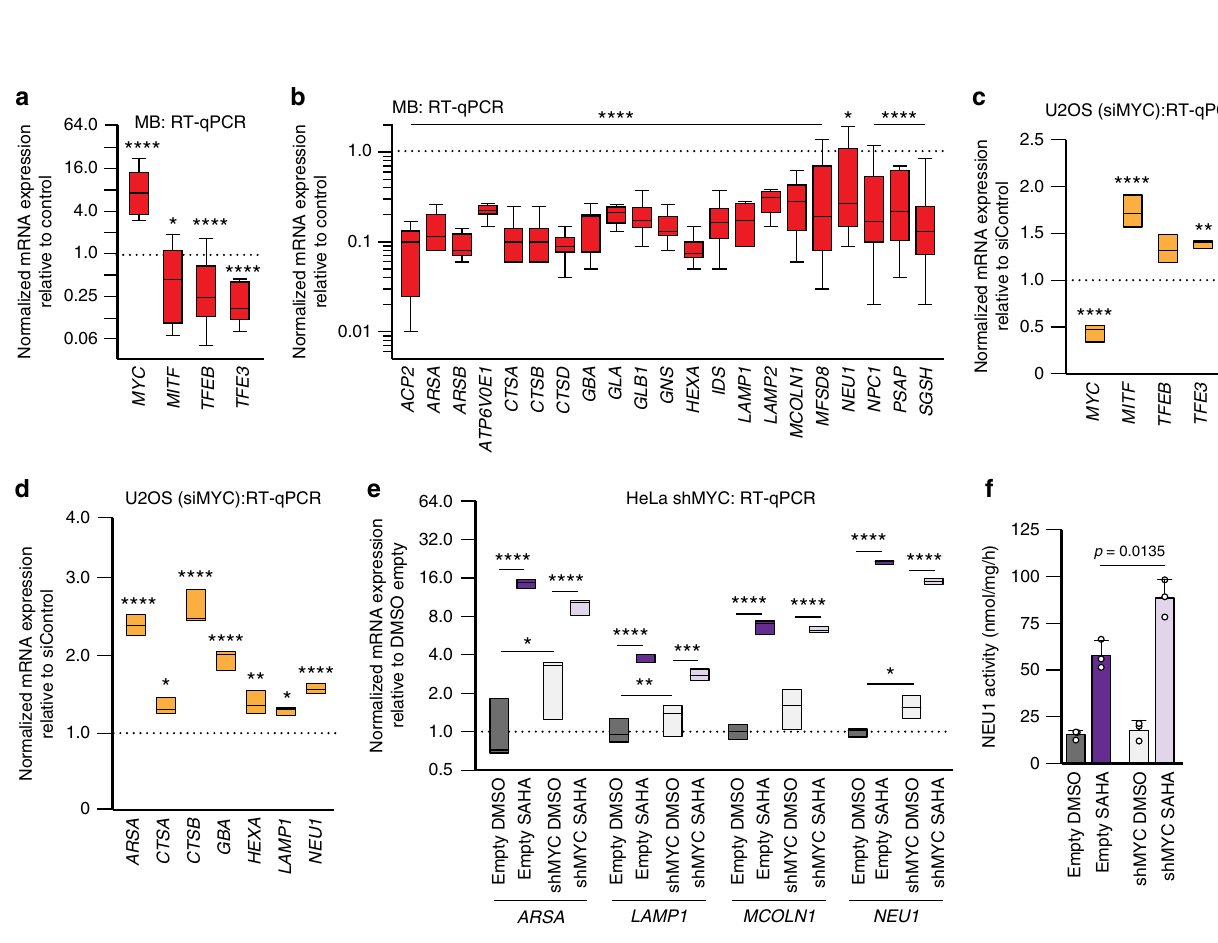
Fig. 4 MYC represses lysosomal gene expression. a , b RT-qPCR of ( a ) Myc , Mitf , Tfeb , Tfe3 and ( b ) lysosomal genes was performed in mouse group 3 medulloblastoma (MB) tumorspheres overexpressing Myc ( Trp53 – / – overexpressing Myc ) and values compared to Trp53 – / – controls ( n = 10 biologically independent samples). c , d RT-qPCR of ( c ) MYC , MITF , TFEB , TFE3 and ( d ) lysosomal genes in U2OS osteosarcoma cells with silenced MYC expression. e RT-qPCR of ARSA , LAMP1, MCOLN1 and NEU1 was performed in HeLa cells silenced for MYC (shMYC), ( n = 6 biologically independent samples) and treated with SAHA (8 μ M for 24 h). f Activity assays for NEU1 in HeLa cells silenced for MYC (shMYC) or infected with a lentiviral empty vector control (Empty) ( n = 3 biologically independent samples) treated with DMSO and SAHA (8 μ M for 24 h). All graphs are presented as mean ± SD. Statistical analysis was performed using the Student t -test. * p < 0.05, ** p < 0.01, *** p < 0.001, **** p <